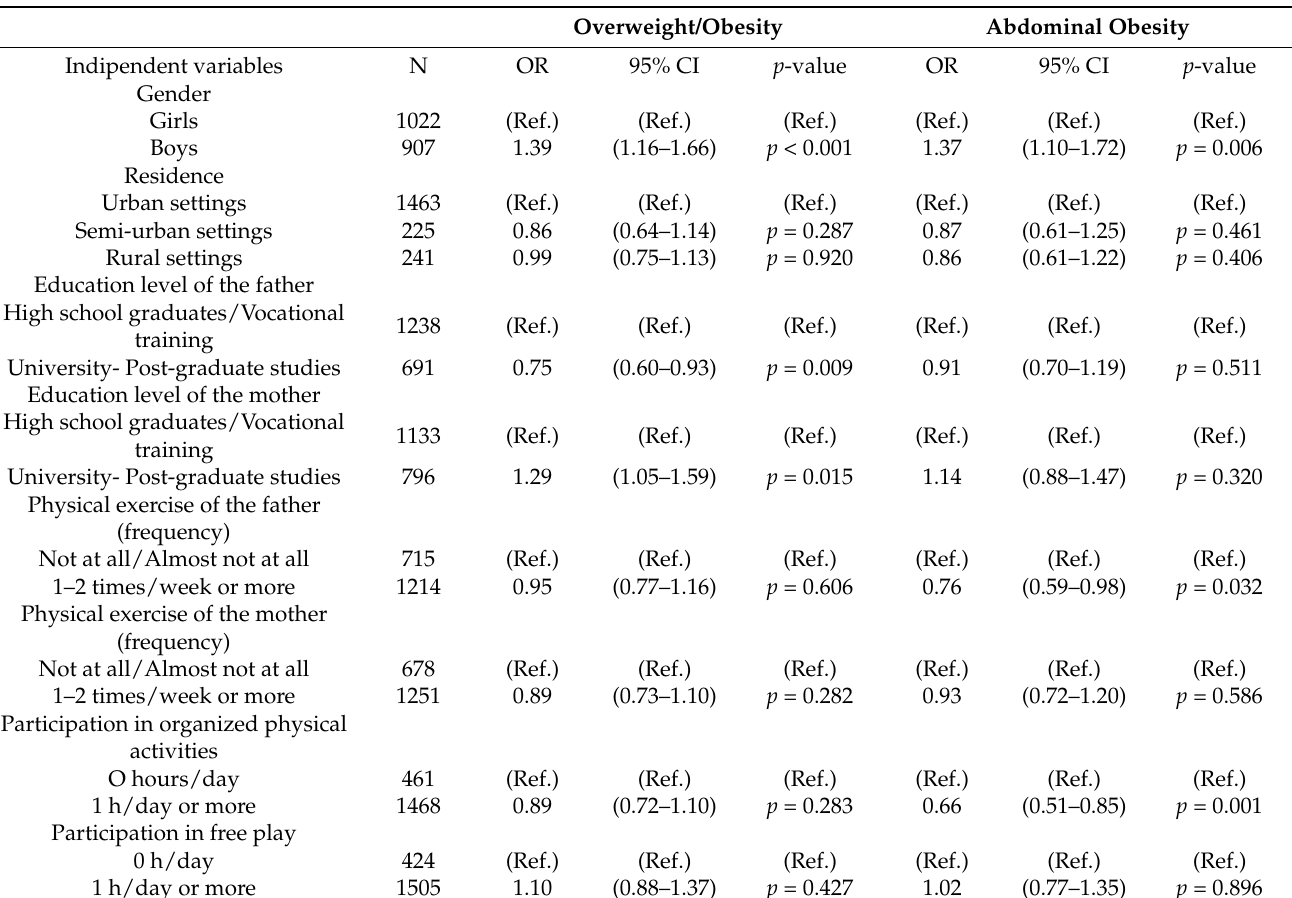
Table 3. Logistic regression analysis models for overweight/obesity (BMIaz ≥ 1) and abdominal obesity (WtHR ≥